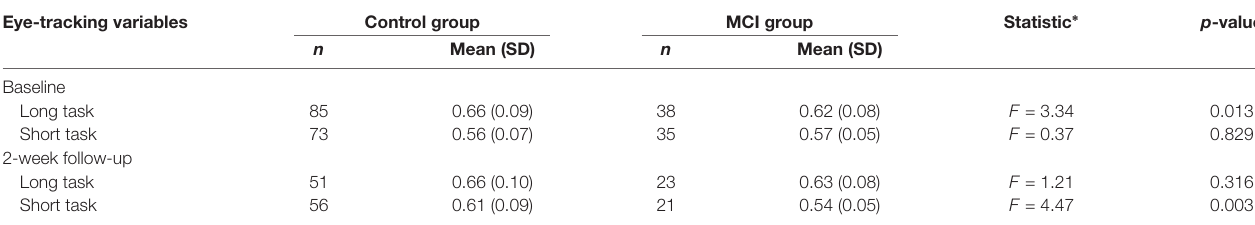
TABLE 2 | Comparison of mean (SD) novelty preferences scores for long task (20 min) and short task (5 min) between patient and controls groups at baseline and at 2-week follow-up using the F -test.